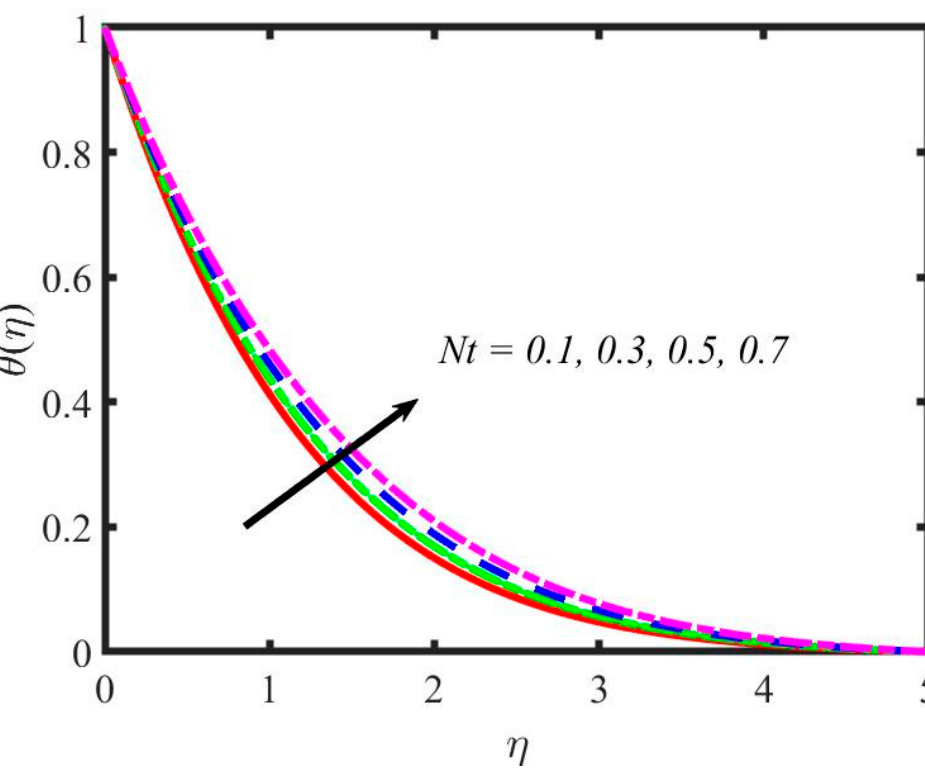
Figure 12. Variations in nanoparticle temperature for thermophoresis parameter.